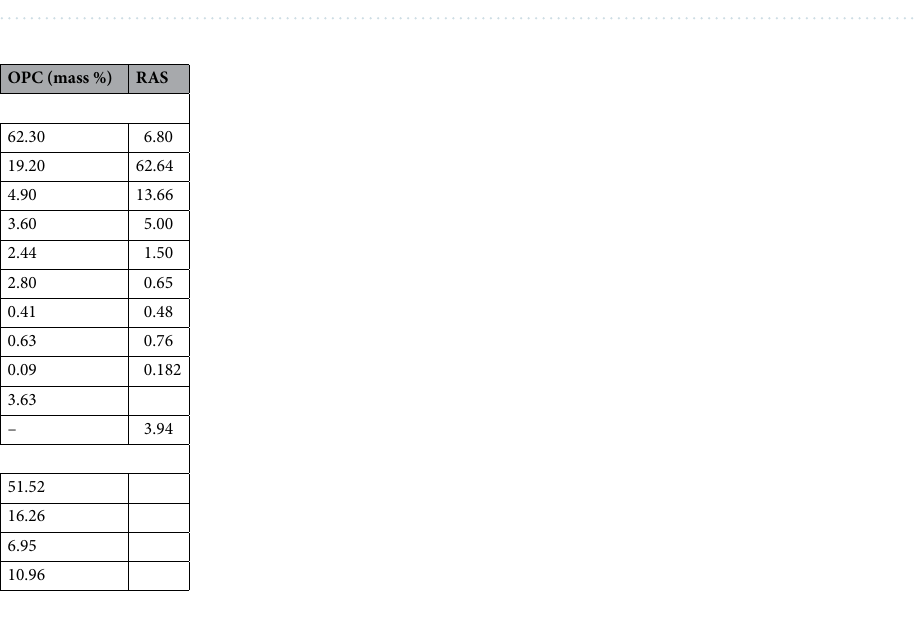
Table 1. (a) The oxide composition of OPC and recycled alum sludge, (b) mineralogical phase compositions OPC (mass, %).